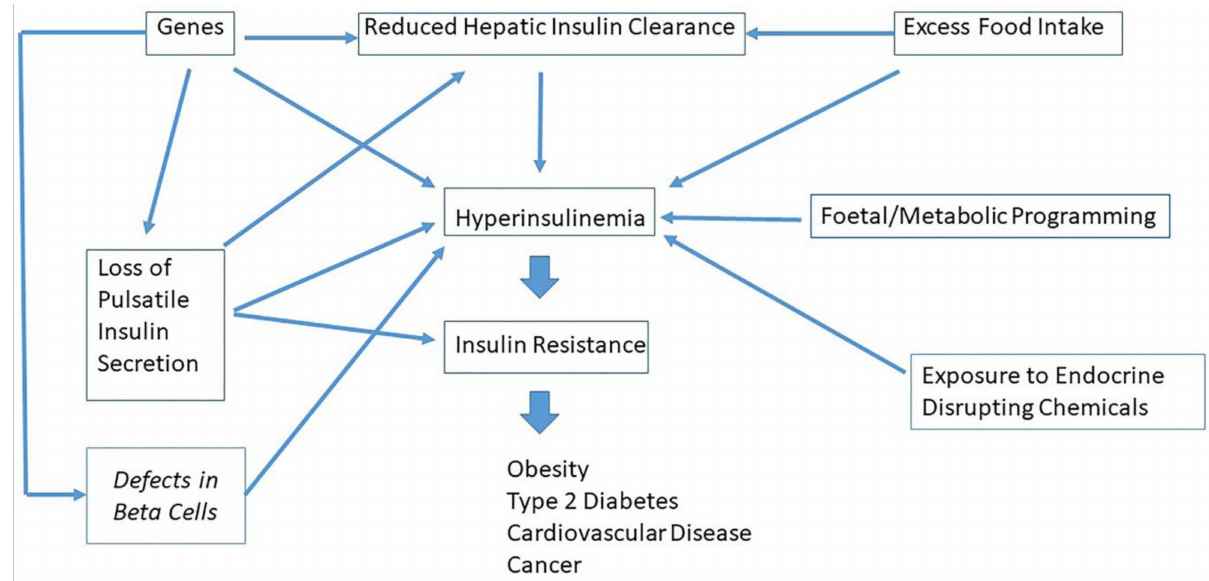
Figure 4. Some factors involved in hyperinsulinemia. Certain genes, hepatic insulin clearance, excess food intake, quality of nutrition, fetal/metabolic programming and exposure to endocrine disrupting chemicals have all been suggested as possible etiological factors in the development of hyperinsulinemia. Loss of pulsatile insulin secretion may contribute to changes in hepatic insulin clearance, hyperinsulinemia and insulin resistance. Note: genes, excess food intake and loss of pulsatile insulin secretion may modify hepatic insulin clearance (see also text for more